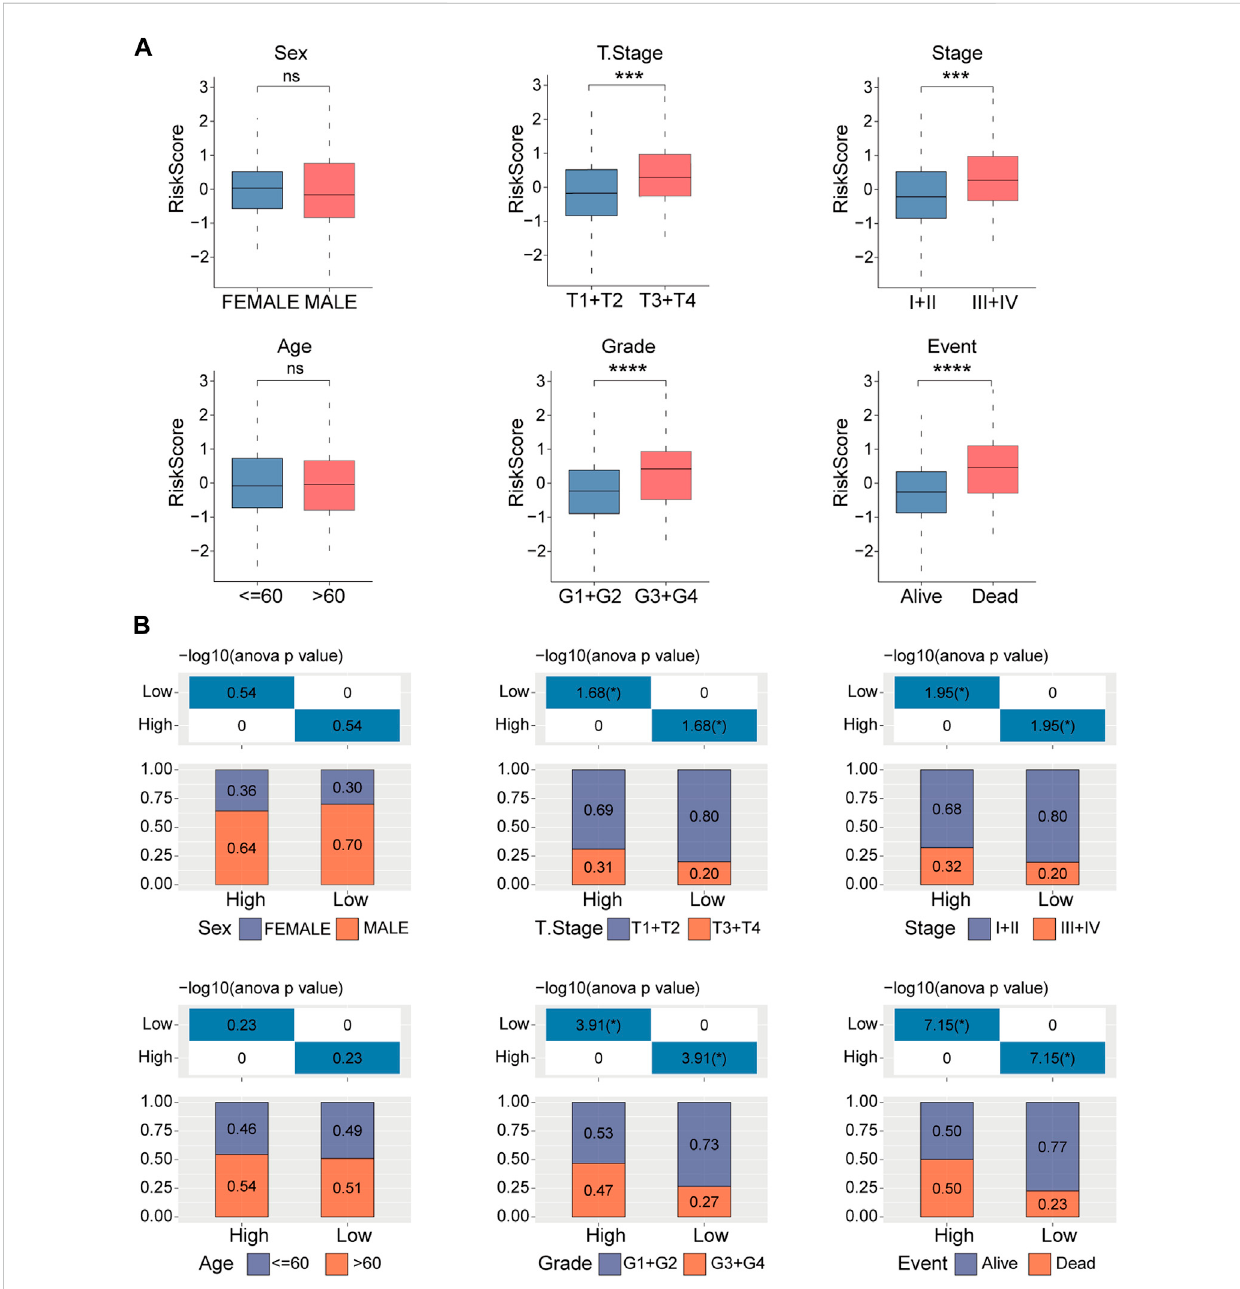
FIGURE 5 Clinicopathologiccharacteristicsanalysesinhigh-andlow-riskgroups. (A) Distributionoftheriskscoreindifferentclinicopathologiccharacteristics including sex, age, tumor size (T), TNM stage, Grade, and survival status. (B) Distribution of the clinicopathologic characteristics in the high- and low-risk groups. ns, no signi fi cance, *** p < 0.001, and **** p <